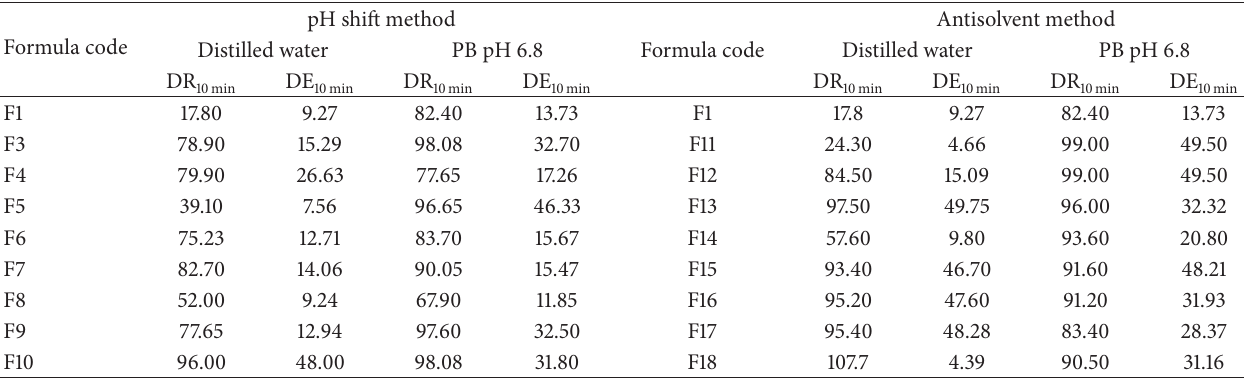
Table 3: Dissolution parameters of ET nanosuspensions prepared by pH shift or antisolvent method in both distilled water and phosphate buffer (PB) pH 6.8.